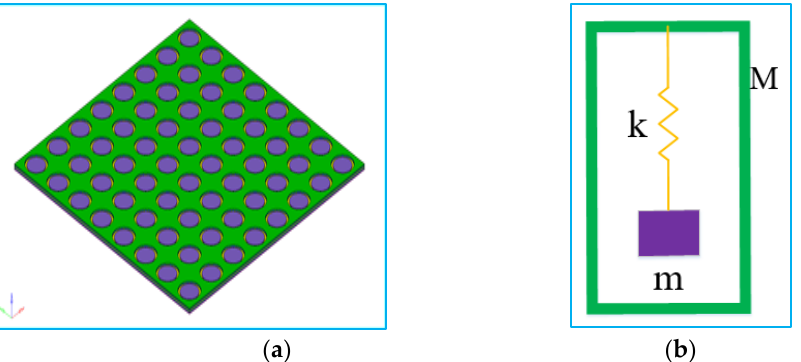
Figure 2. Typical local resonant acoustic metamaterial crystal cell structure and simplified model.